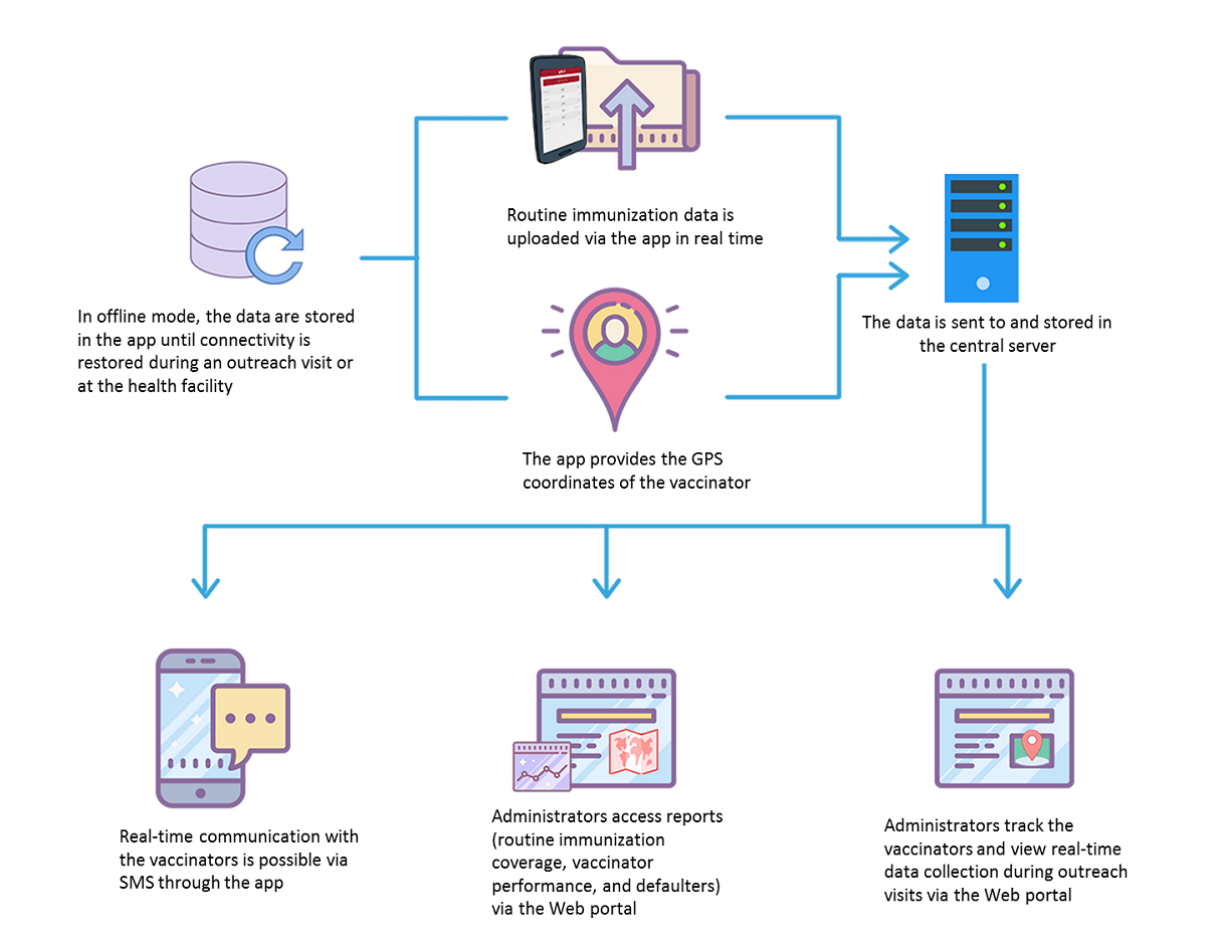
Figure 4. Flow of data through the Teeko app and Web